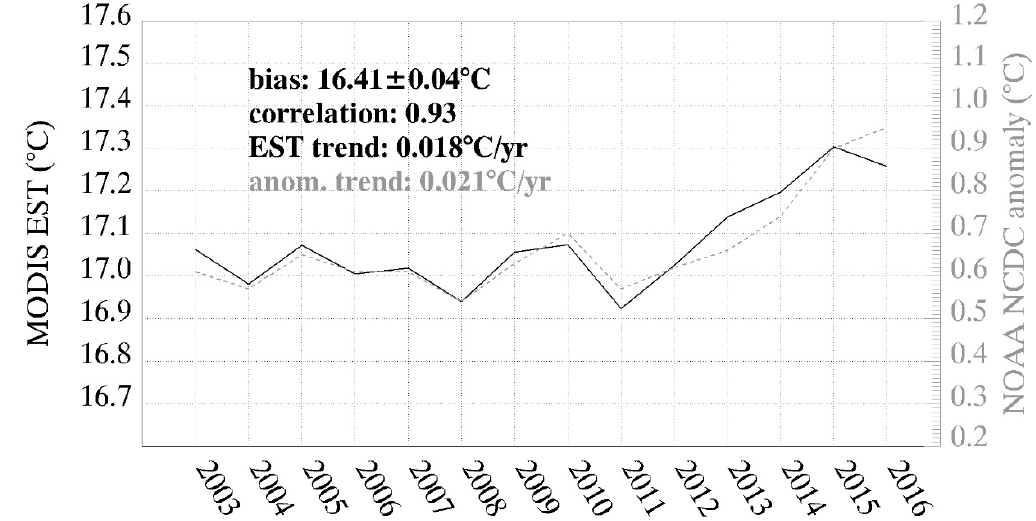
Figure 1. MODIS EST absolute temperature versus NOAA-NCDC anomalies. Both datasets estimate positive global surface temperature trends, which are, respectivaly 0.018 °C/yr. for MODIS EST and 0.021 °C/yr. for NOAA NCDC and their correlation coefficient is 0.93.